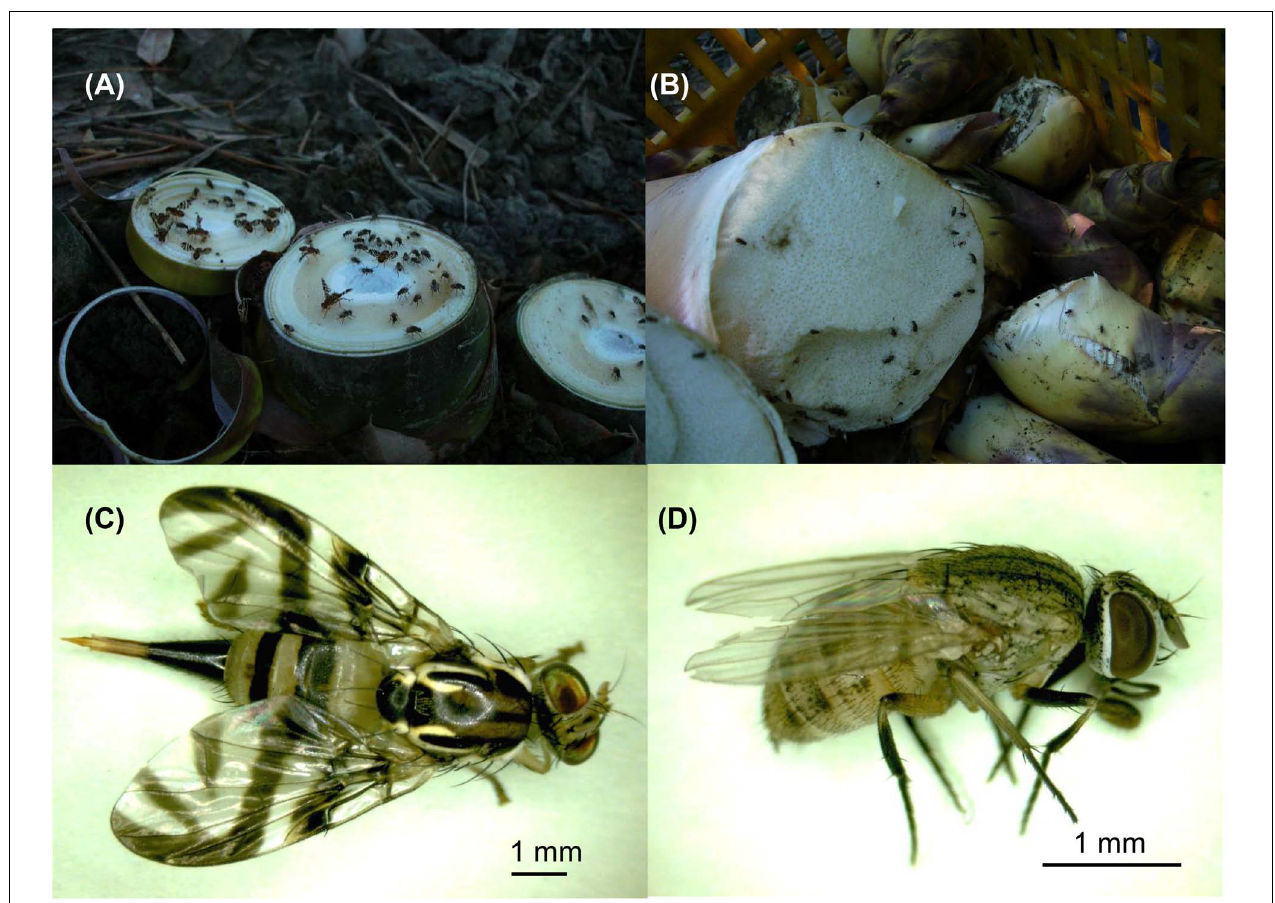
FIGURE 1 | The main insect species collected in bamboo plantations in southern Taiwan. (A) After the harvesting of the bamboo shoots, the cut surfaces exposed on the ground attracted many dipteran insects within minutes. (B) The surface of the harvested bamboo shoots also attracts some dipetran insects. The most abundant dipteran insects were identified as Gastrozona fasciventris (C) and Atherigona orientalis (D) ,